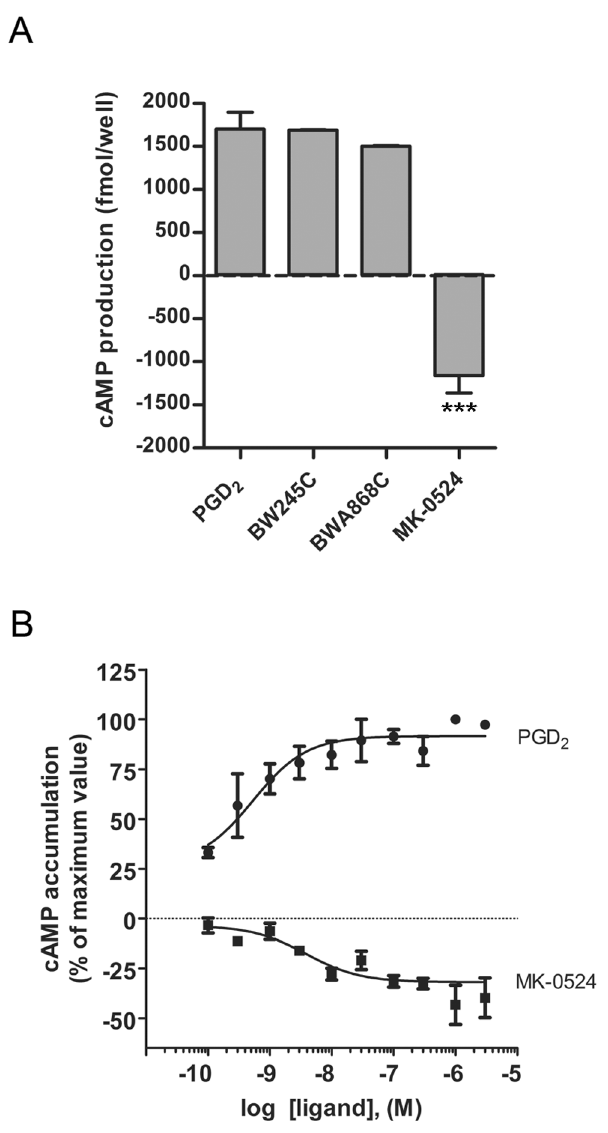
Figure 1. MK-0524 reduces DP1 cAMP signaling below basal levels. HEK293 cells transiently expressing Flag-DP1 were stimulated with 10 nM (A) or increasing concentrations (B) of the indicated ligands for 10 min and cAMP levels were measured as described in ‘‘Materials and Methods’’. Results are presented in fmol/well above or below basal cAMP production by DP1 in absence of ligand (set at 0) (A) or as the % of the maximal response obtained with PGD 2 stimulation (B). Data are the mean 6 S.E. of at least three independent experiments. *** is